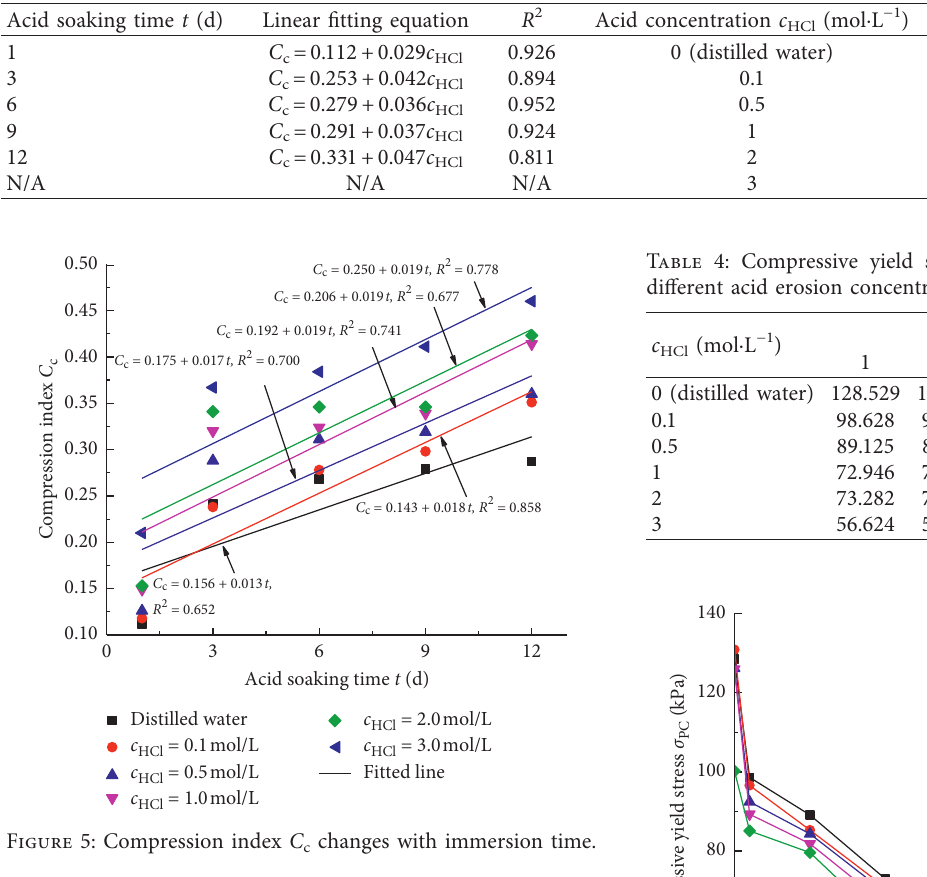
Table 3: The linear fitting equation for the compression index C